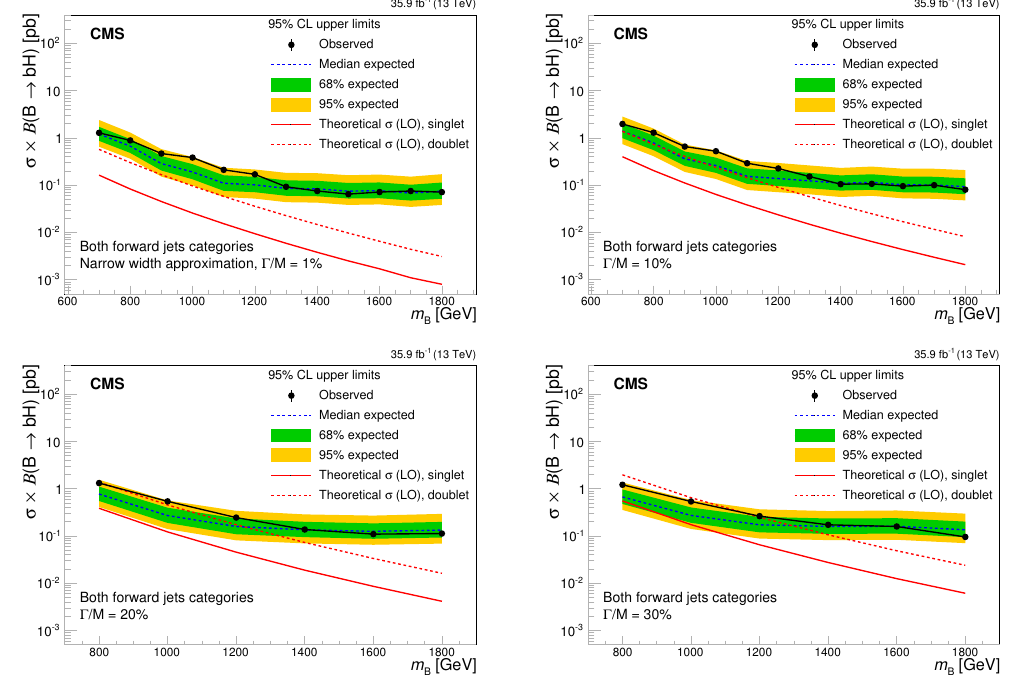
Figure 6. The median observed and expected 95% CL upper limits on the product of the B quark production cross section and branching fraction as a function of the signal mass, assuming narrow- width resonances (upper-left) and widths of 10 (upper-right), 20 (lower-left), and 30% (lower-right) of the resonance mass for the B quark. The results are shown for the combination of 0 and > 0 forward-jet categories. The continuous red curves correspond to the theoretical expectations for singlet and doublet